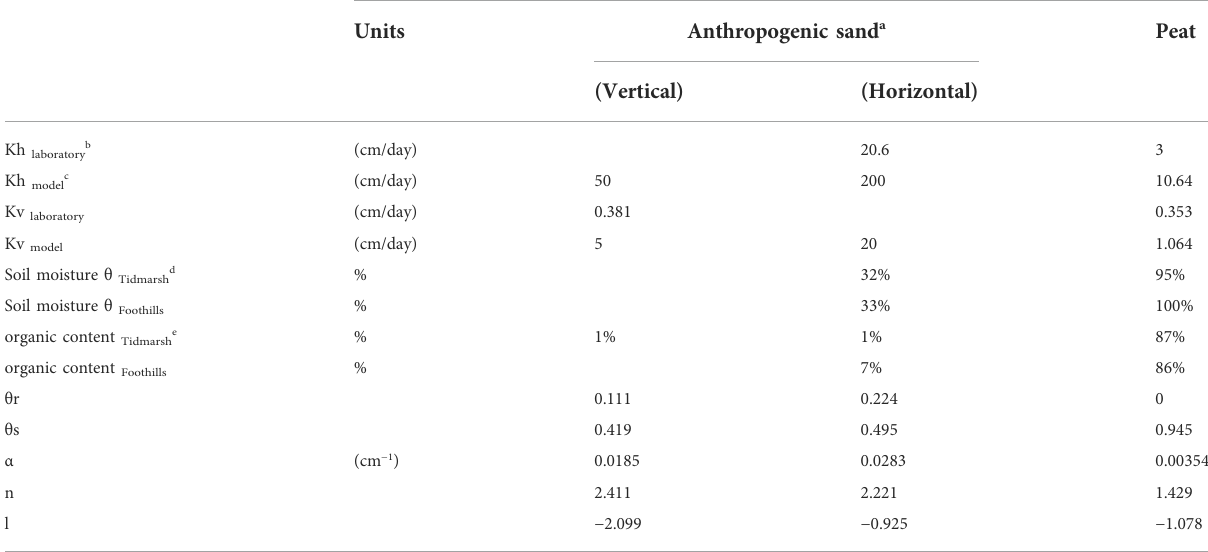
TABLE 5 Summary of material hydrogeologic properties.